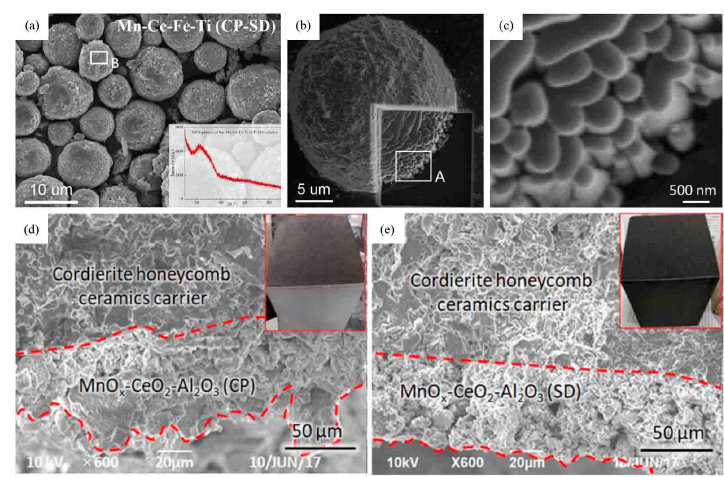
Figure 11. ( a ) The SEM image of nanoporous microspheres Mn-Ce-Fe-Ti mixed oxide catalysts, ( b ) focused ion beam (FIB) images and ( c ) SEM image of nanoporous microspheres Mn–Ce-Fe-Ti [185], ( d ) SEM images of MnO x -CeO 2 -Al 2 O 3 (CP-MHC), and (e) MnO x -CeO 2 -Al 2 O 3 (SD-MHC) [159]. Reproduced from Ref. [159], Copyright 2018, Elsevier.